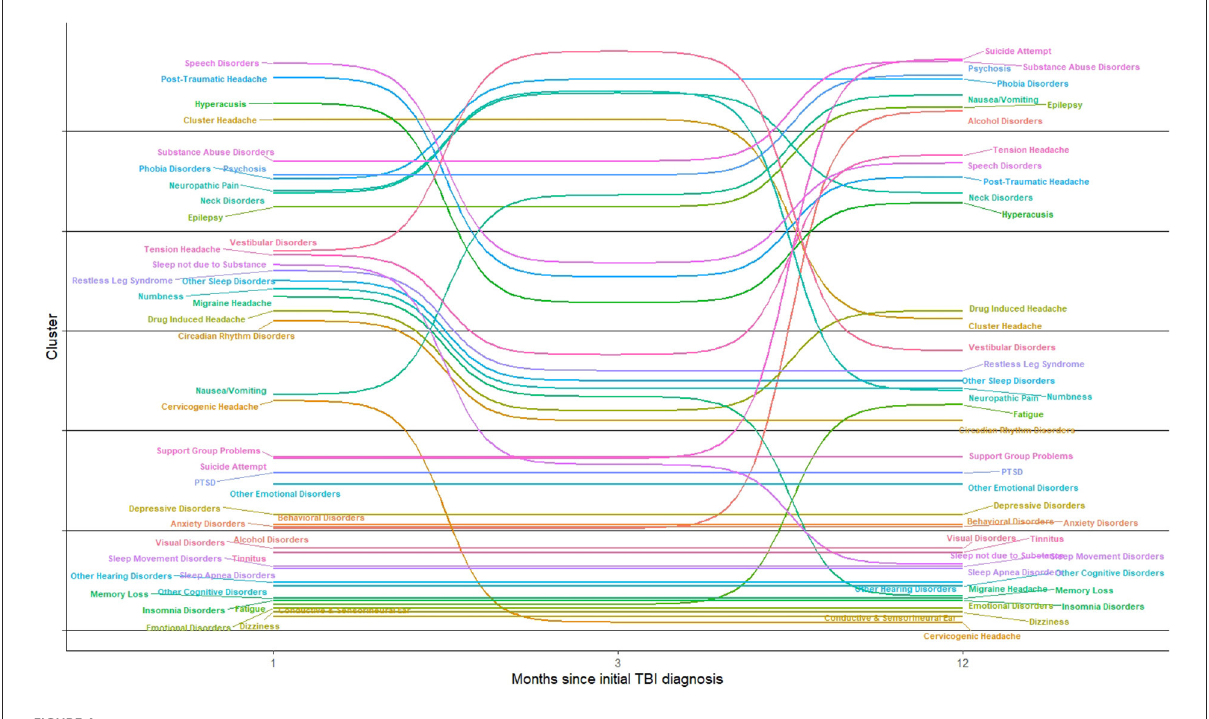
FIGURE4 Changing composition of clusters one month, three months, and one year